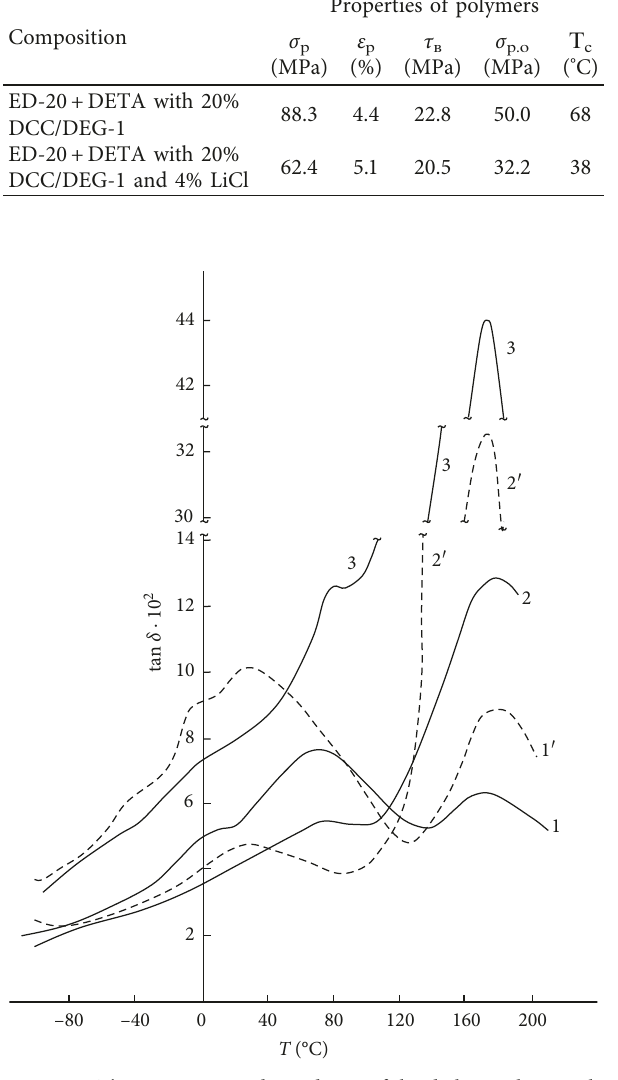
Figure 3: The temperature dependence of the dielectric loss angle tangents at a frequency of 10 6 Hz (1–3) and 10 5 Hz (1